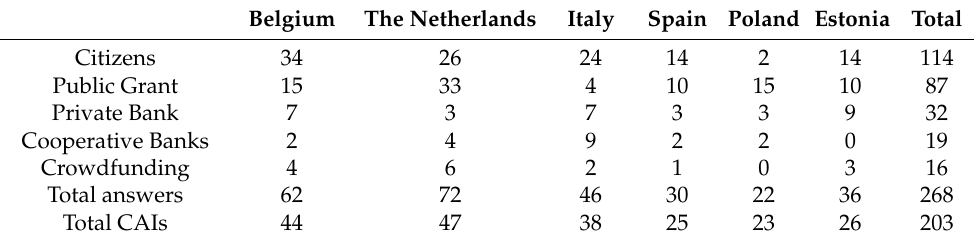
Table 3. The main initial